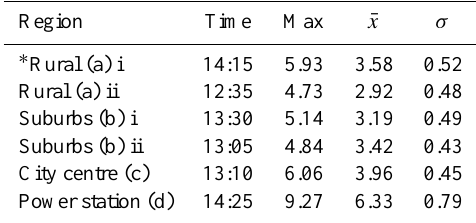
Table 4. VCD max, mean ( ¯ x ) and standard deviations ( σ ) in (molec cm − 2 × 10 16 ) from selected areas within the ANDI gridded data (see Fig. 13). ∗ Rural (a) i is an anomaly discussed in Sect. 4.6. The times presented are the approximate measurement times for each region.